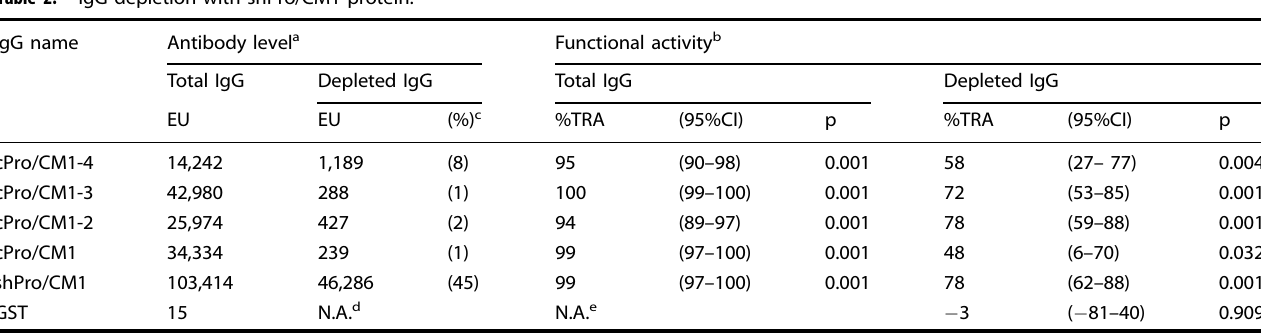
Table 2. IgG depletion with shPro/CM1